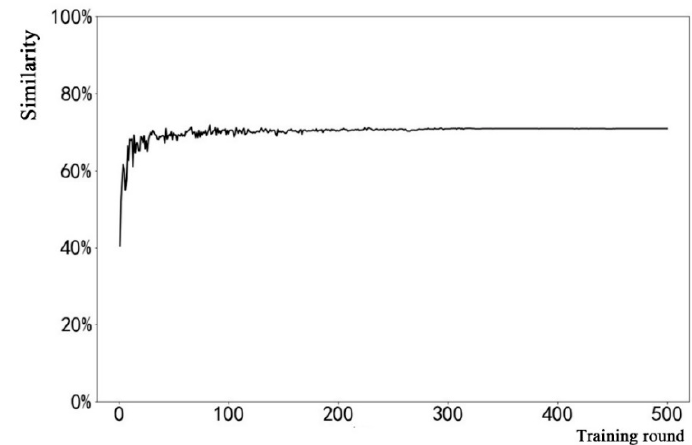
Figure 13. Similarity curve of the geostratigraphic series.